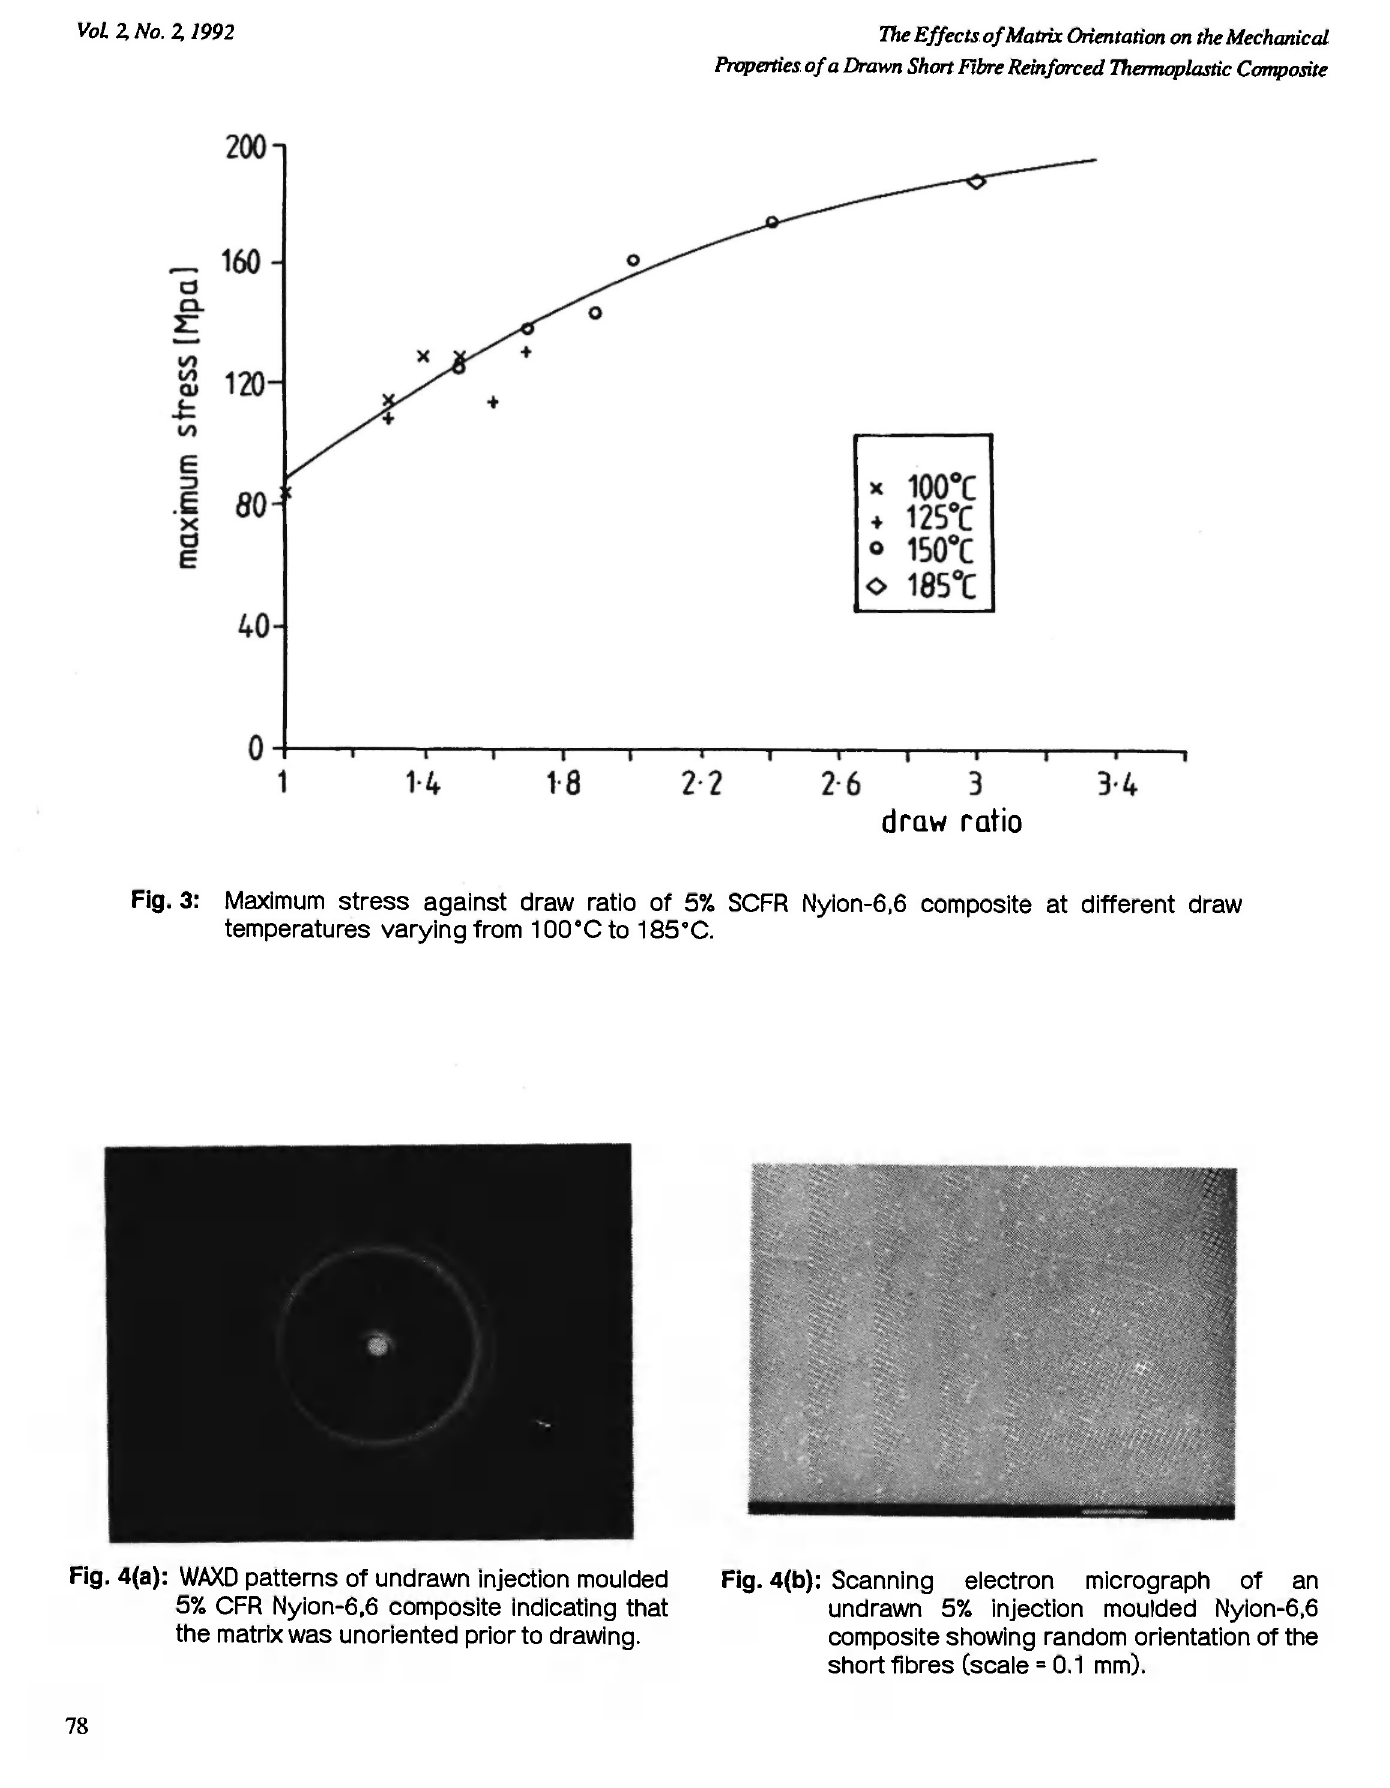
Fig. 4(b): Scanning electron micrograph of an undrawn 5% injection moulded Nyion-6,6 composite showing random orientation of the short fibres (scale = 0.1